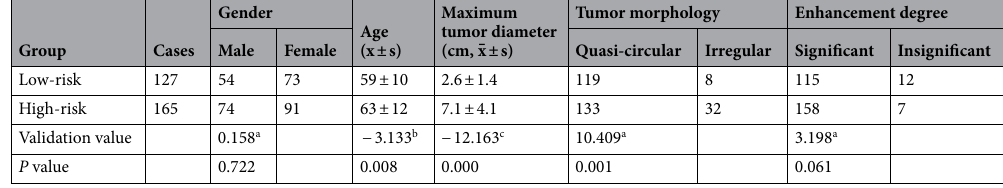
Table 1. A comparison between the general information of the two groups. a χ 2 value, b t value, c Z